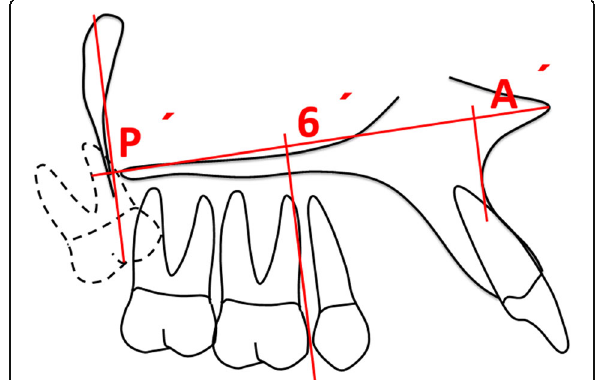
Fig. 3 MPDD evaluated by the ratio of the anterior maxillary base